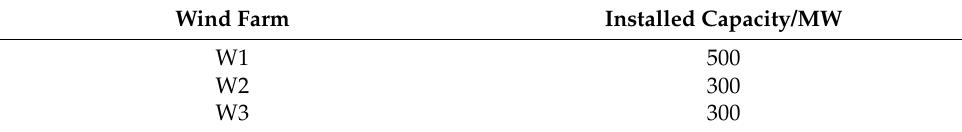
Table 2. Basic parameters of wind farms.